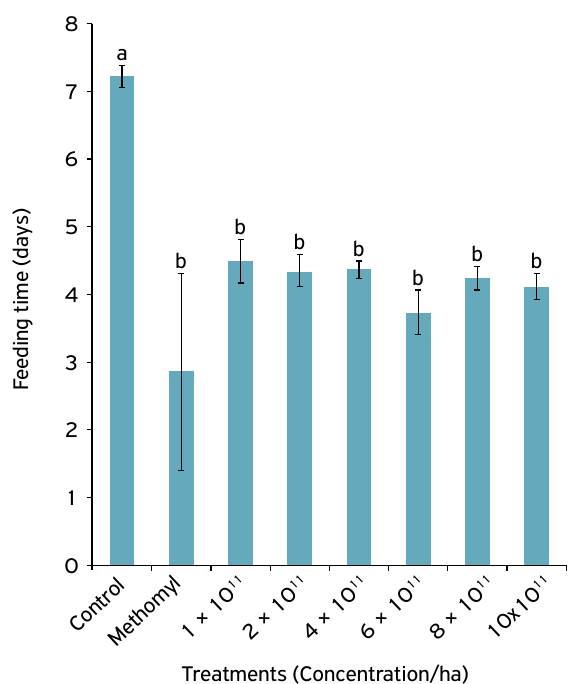
Figure 2. Average feeding time ( ± SE) of Chrysodeixis includens larvae (3 rd instar) after ingestion of soybean leaf discs either submerged or not (control) into six concentrations of isolate Chin-IA (I-A) (ChinNPV) and one dose of the chemical insecticide (methomyl).